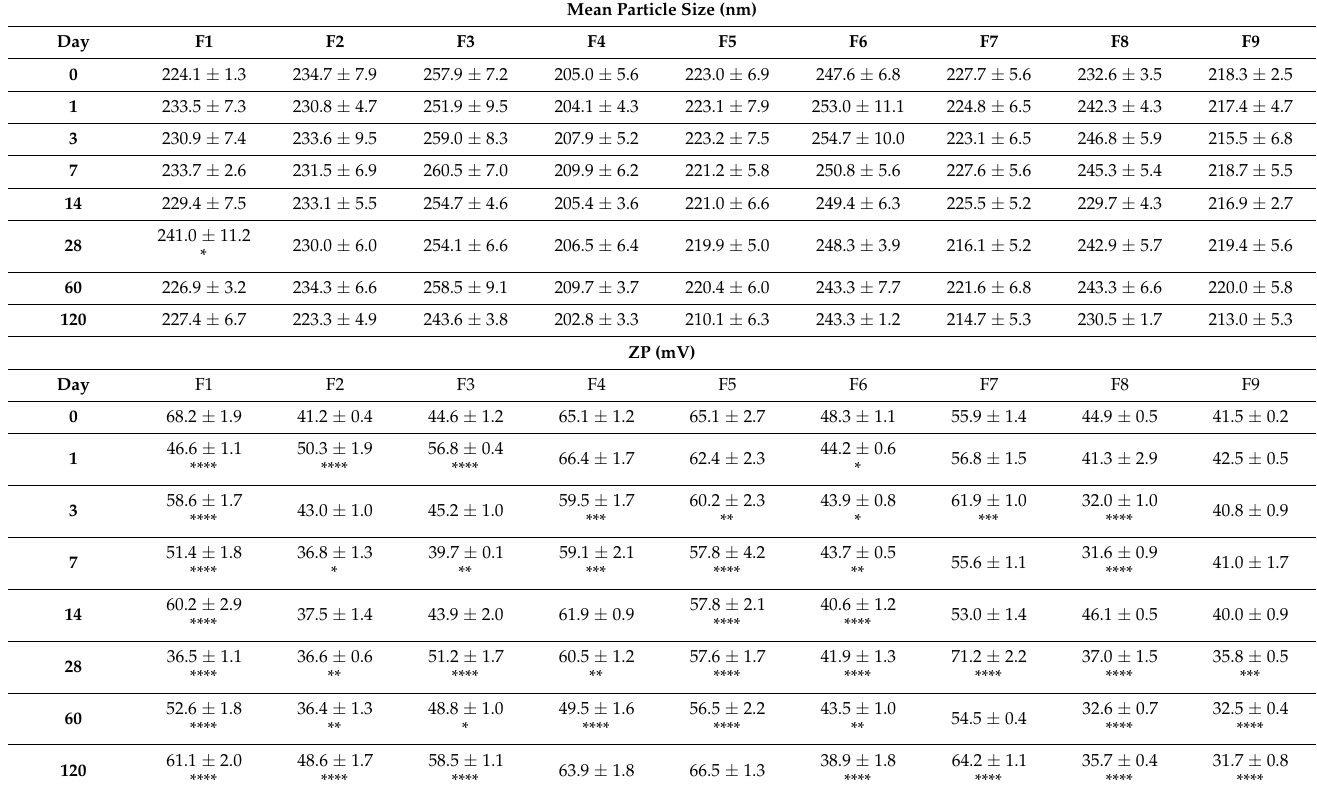
Table 3. Mean size and zeta potential variations of the developed nine nanoemulsions with TA, stored at 4 ◦ C over a period of 120 days. Results are the mean of three replicates ± standard deviation (S.D.). Statistical significance * p < 0.05; ** p < 0.01; *** p < 0.001; **** p < 0.0001 vs. day